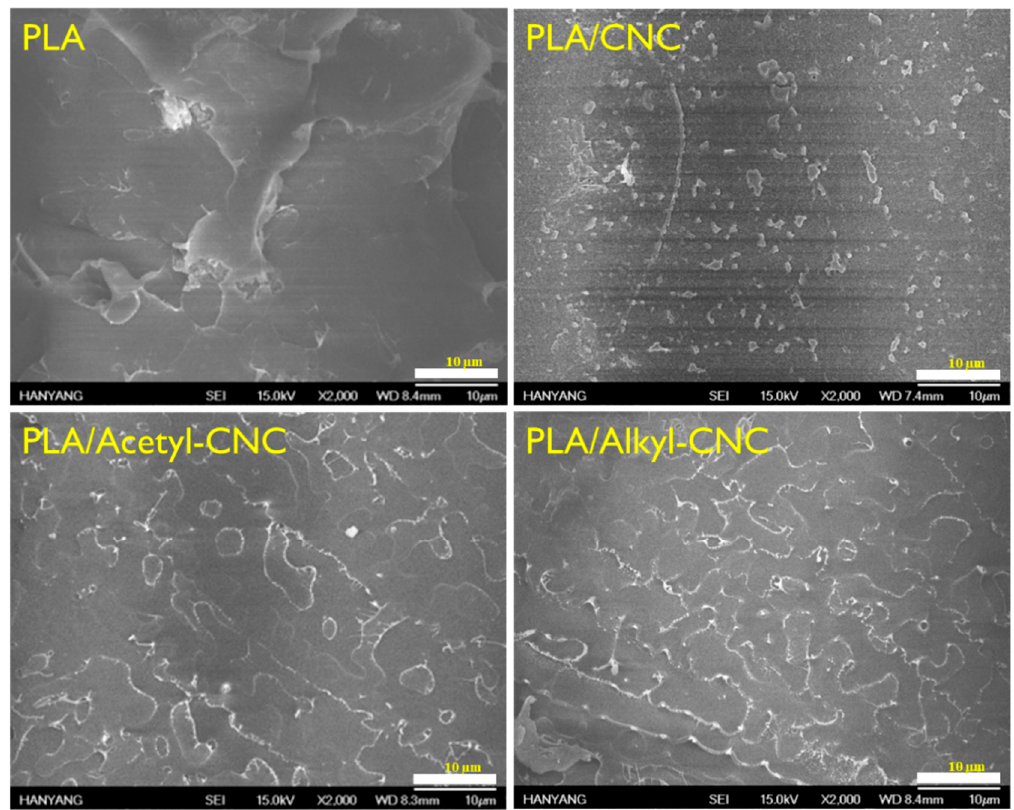
Figure 3. SEM images of PLA and PLA nanocomposites with 1 wt % CNC, acetyl-CNC, and alkyl-CNC.